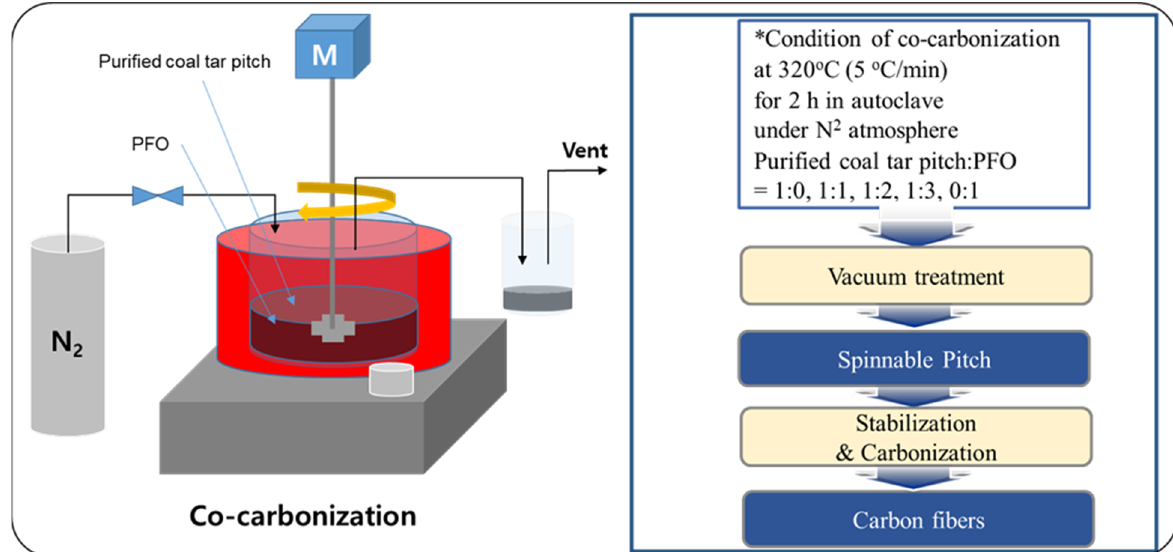
Figure 1. Illustration of the production of isotropic carbon fiber by